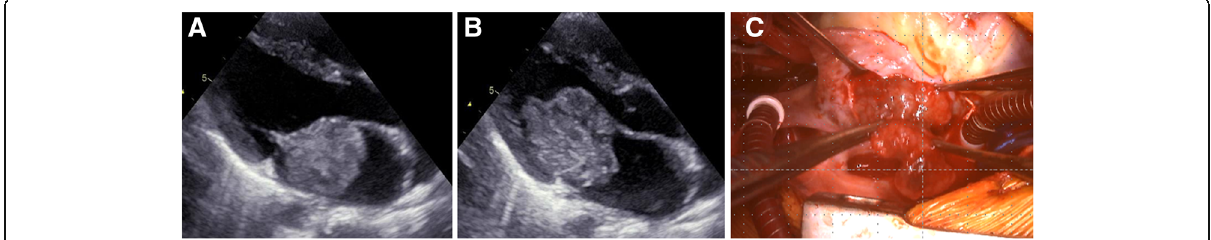
Fig. 2 Echocardiography shows a giant mass in the left atrium ( a ), which prolapsed into the left ventricle during diastole ( b ). c A giant